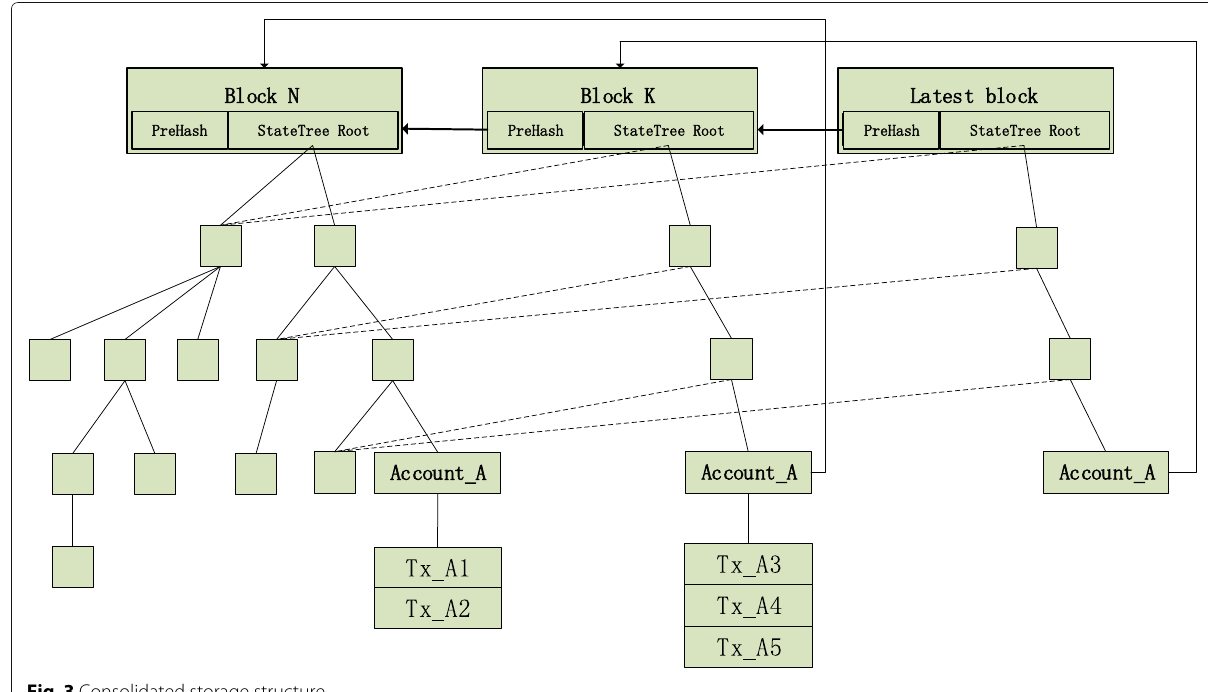
Fig. 3 Consolidated storage structure the new transaction will increase by 1, and the block num- ber is assigned a value of 1. The block with block number